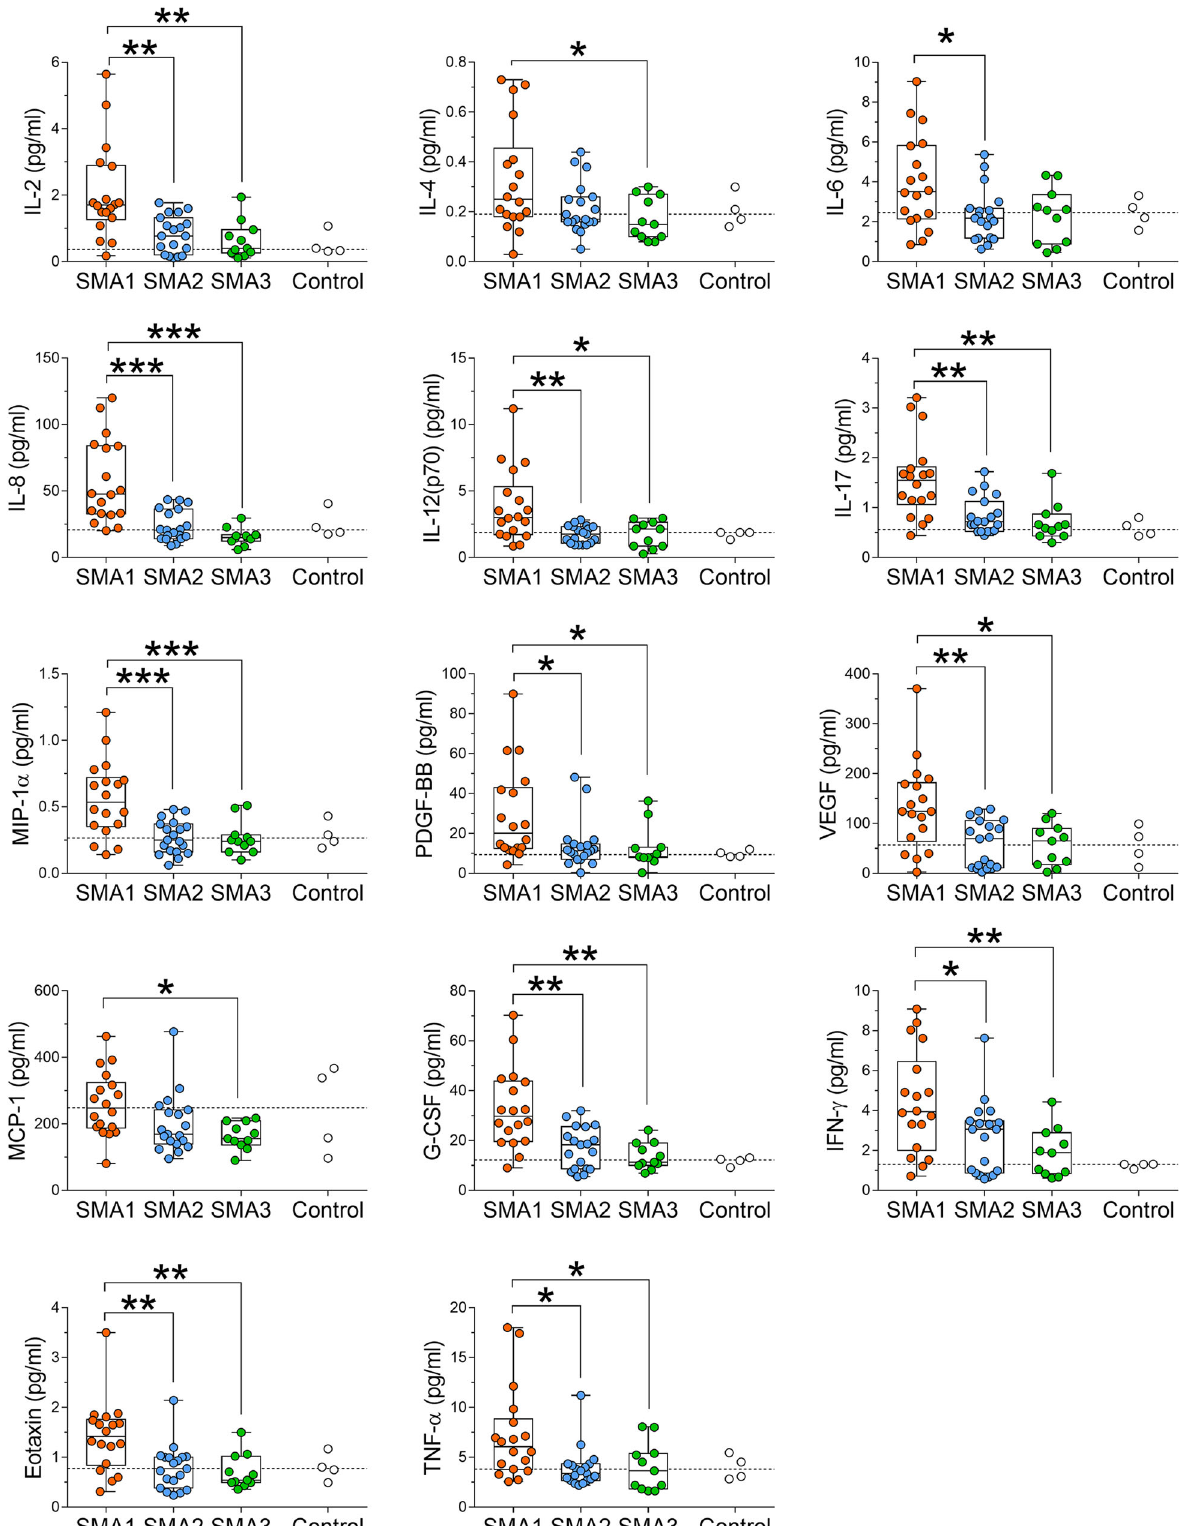
Fig. 1 Levels of cytokines and neurotrophic factors in the CSF of naive SMA patients. Increased levels of IL-2, IL-4, IL-6, IL-8, IL-12 (p70), IL-17, MIP-1 α , PDGF-BB, VEGF, MCP-1, G-CSF, IFN- γ , eotaxin and TNF- α are found in the CSF of SMA1 ( n = 18) patients compared to SMA2 ( n = 19) and/or SMA3 ( n = 11) patients. Controls ( n = 4) were used as a reference for physiological levels of cytokines. Data are shown as box and whisker plots representing median with interquartile range (IQR). * p < 0.05, ** p < 0.01; *** p < 0.0001, compared to SMA2 or SMA3 (Bonferroni multiple comparisons). Dots represent individual patients ’ values. The dotted line represents the median of control